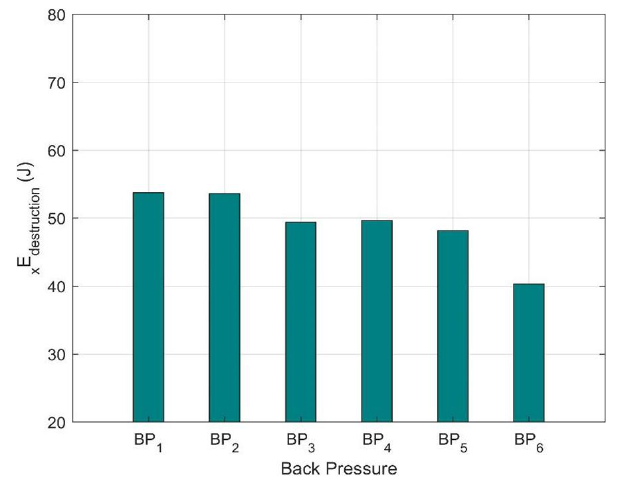
Figure 18. Exergy destruction in